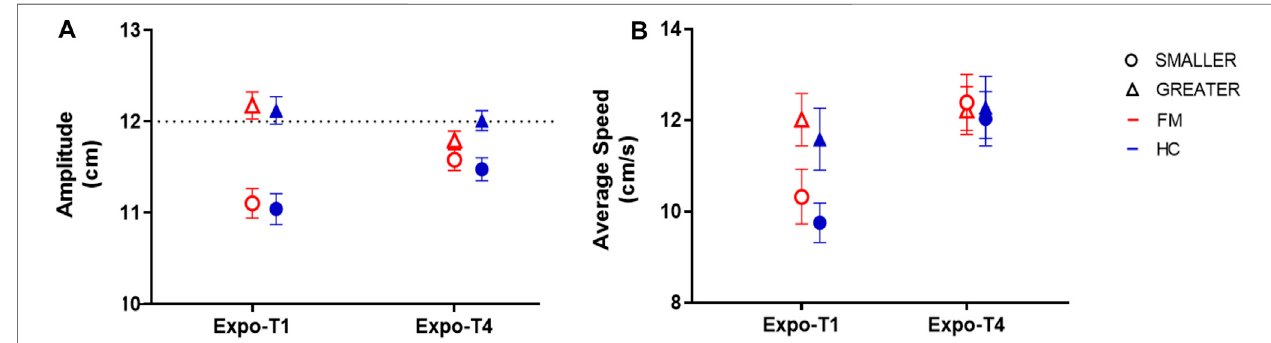
FIGURE 5| Adaptation to altered visual feedback (VF) upon exposureacrossgroups. (A) Asexpected, Movementamplitude increased over time in the SMALLER VF condition (circles), but decreasedin theGREATER VF condition (triangles). Thesechangesweresimilar inparticipants with fi bromyalgia (FM; red empty symbols)and healthy controls (HC; blue fi lled symbols) (B) Both groups adapted their Average Speed in a way that is consistent with the displayed VF condition, but this adaptation was similar across groups. Error bars represent standard error of the mean.